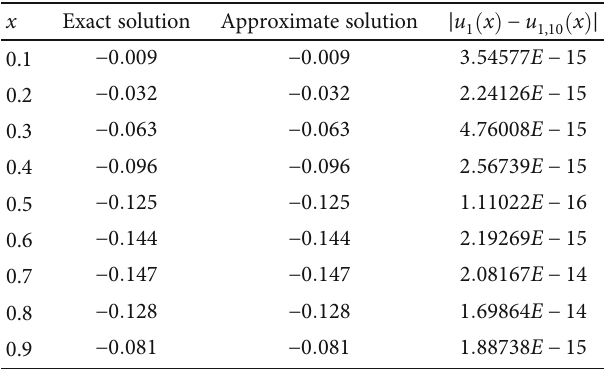
1 obtained by the present method